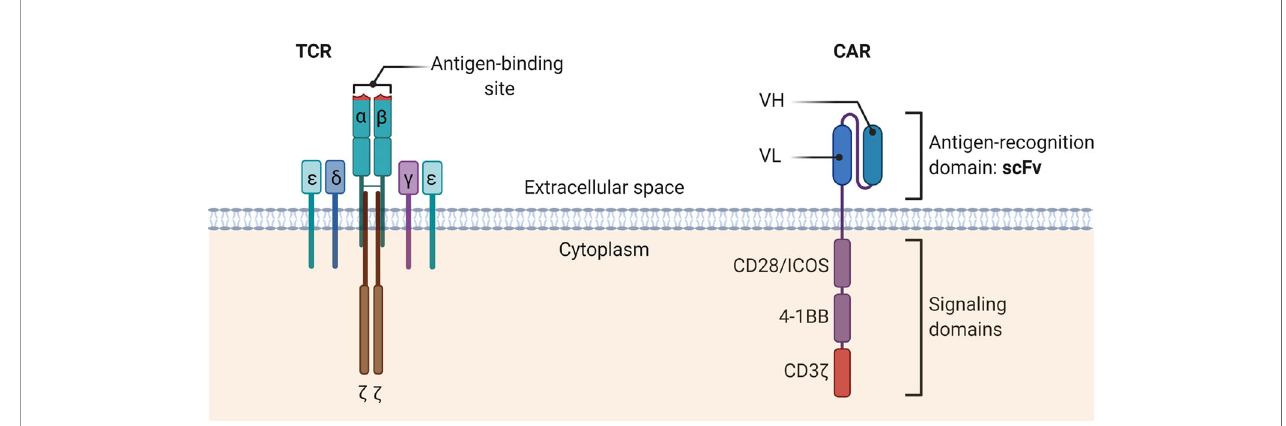
FIGURE 2 | The schematic diagrams of the structures of TCR complex and CAR. The TCR a and b chains bind the MHC-peptide on antigen-presenting cells. Other CD3 molecules, especially the CD3 z , transmit signals and activate the T cells. TCR, T cell receptor; CAR, Chimeric antigen receptor; scFv, Single-chain variable fragment; VH, heavy chain variable domain; VL, light chain variable